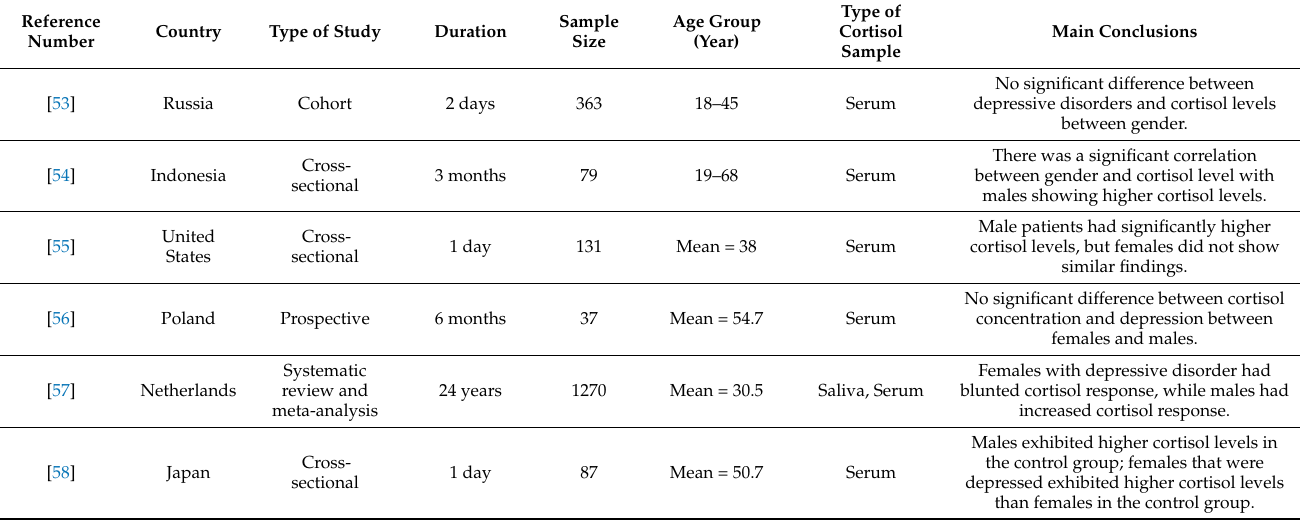
Table 3. Serum mixed-gender studies investigating the relationship between cortisol and